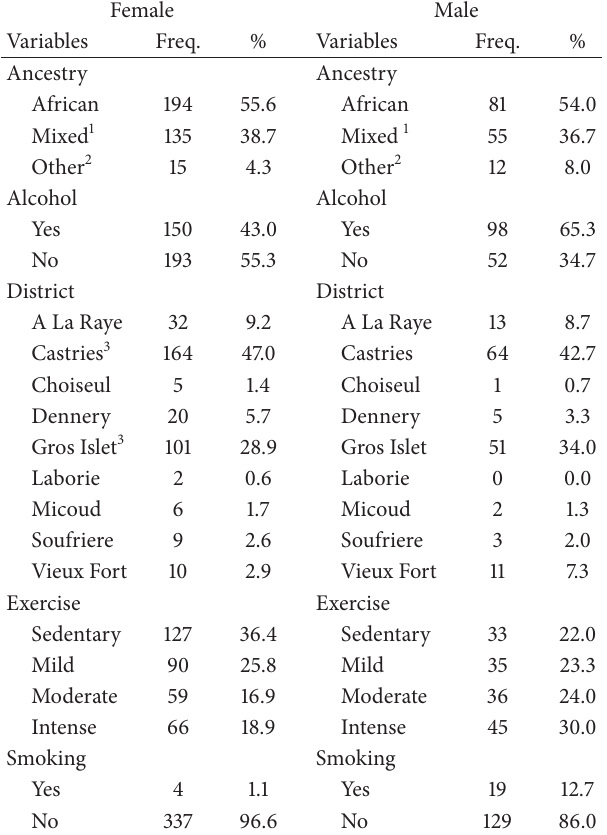
for metabolic syndrome. Women’s HDL was 55.09 which was higher than the men’s mean HDL of 46.39. A